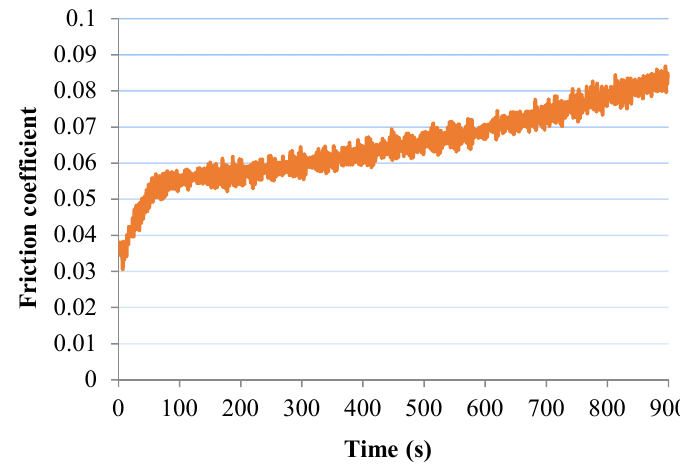
Figure 7. Friction Coefficient (COF) variation with testing time for the Extrudr BDP Flax sample.